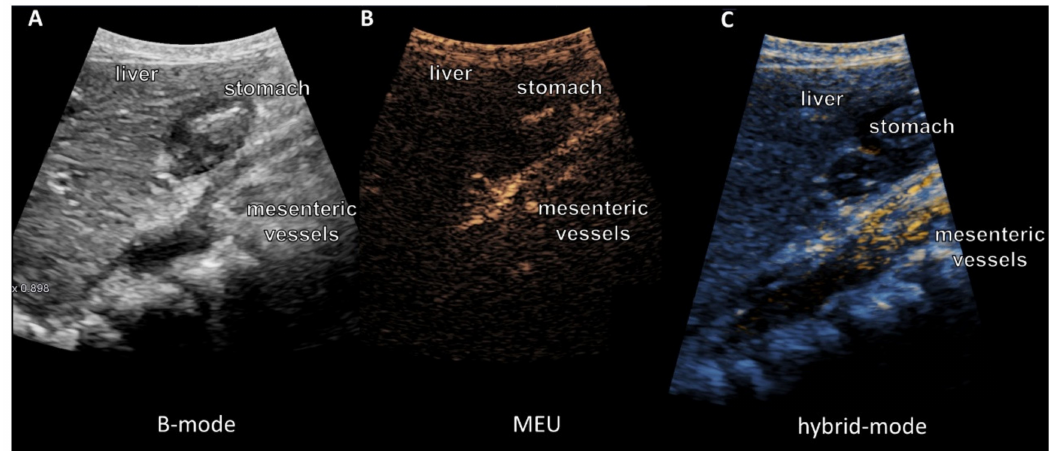
Figure 6. High resolution Ultrasound, multi-frequency C1-6 MHz probe, direct comparison of B-mode ( A ), microbubble enhanced ultrasound (MEU) ( B ), and hybrid mode ( C ) 90 minutes after liposomal vitamin C uptake. ( A ) B-mode after application of the microbubbles with vitamin C ( B ): enhanced signal in the subtraction image with low MI ≤ 0.16, high signal intraluminal in the stomach-duodenum, mesenteric vessels, and liver corresponding to the enhancement of the MEU. ( C ) Visualization of the microbubbles with the hybrid subtraction mode. Clear enhancement of the bubbles in the intraluminal vessels, stomach / duodenum, and